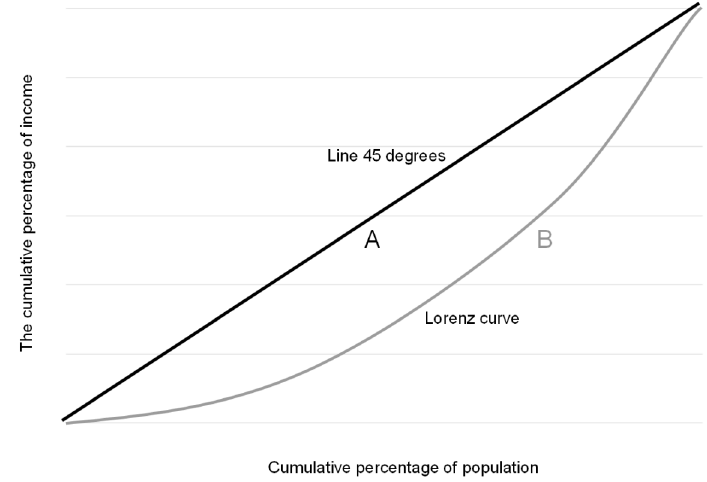
Figure 3. Lorenz Curve and Gini